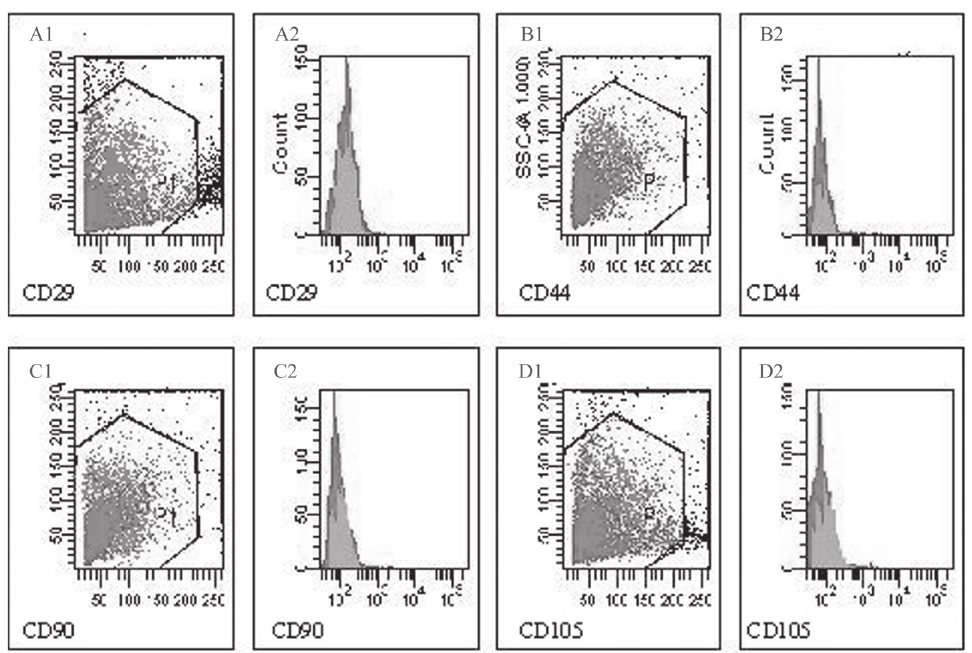
Fig. 5. Surface antigens of hAM-dMSCs were cultured in the QDs suspension. In flow cytometry, hAM- dMSCs labeled with 0.75 μg/mL QDs were positive for CD29 (A1, A2), CD44 (B1, B2), CD90 (C1, C2) and CD105 (D1, D2) at 4 d. Data are shown as the mean ± standard error (S.E.)